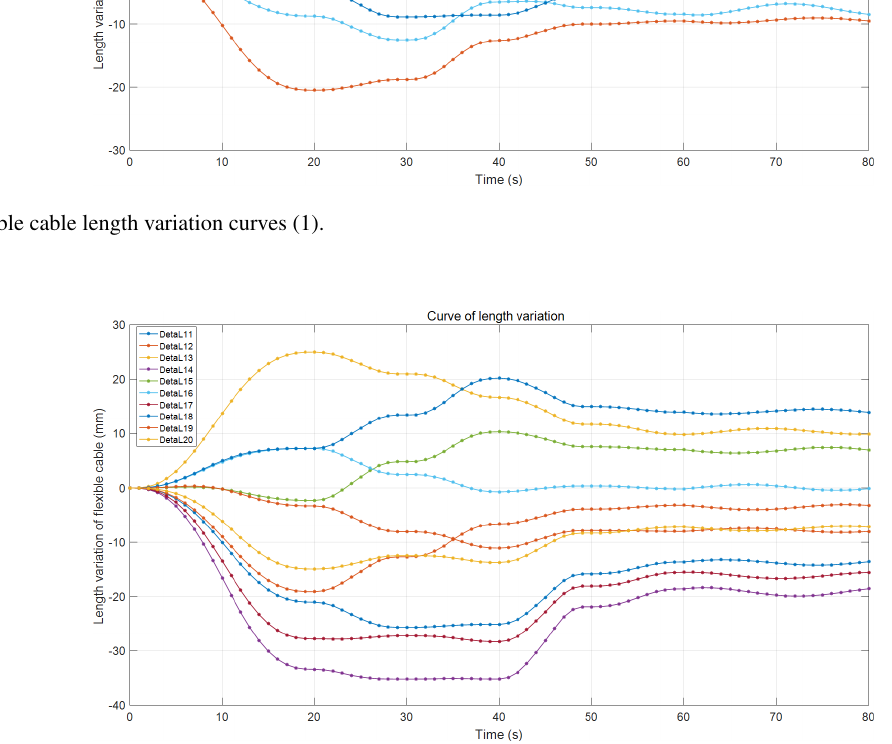
Figure 10. Flexible cable length variation curves (2).